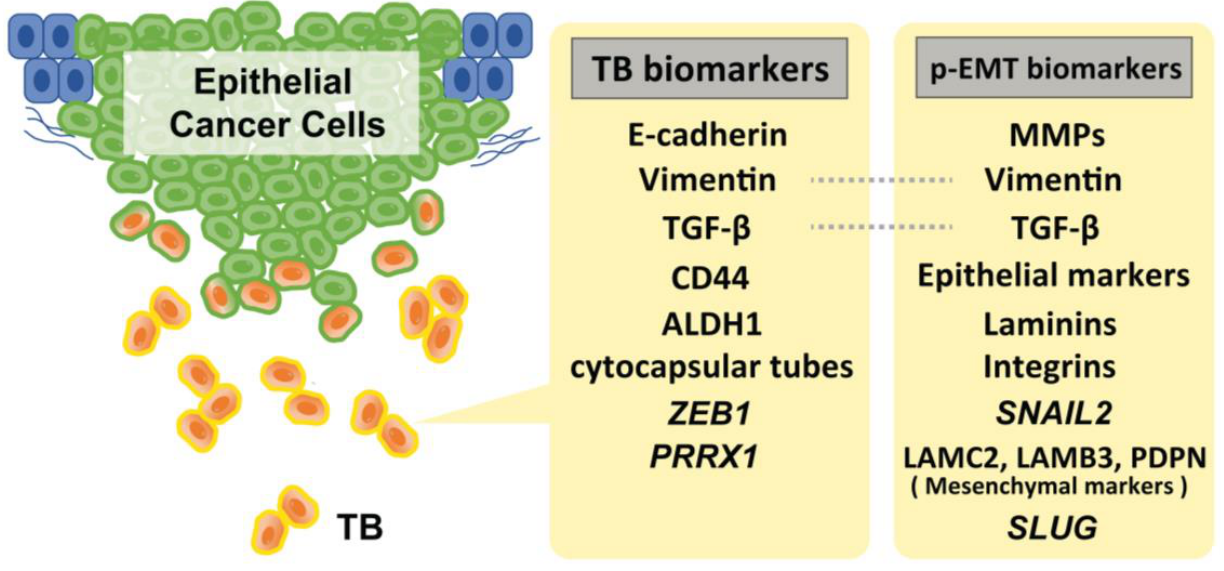
Figure 1. Representative biomarkers of TB and p-EMT. Of note, SNAIL2 amplification is strongly specific to the p-EMT status. Although several markers for these statuses have been reported, there is a lack of verification of the specificity of these markers to distinguish TB and p-EMT status.